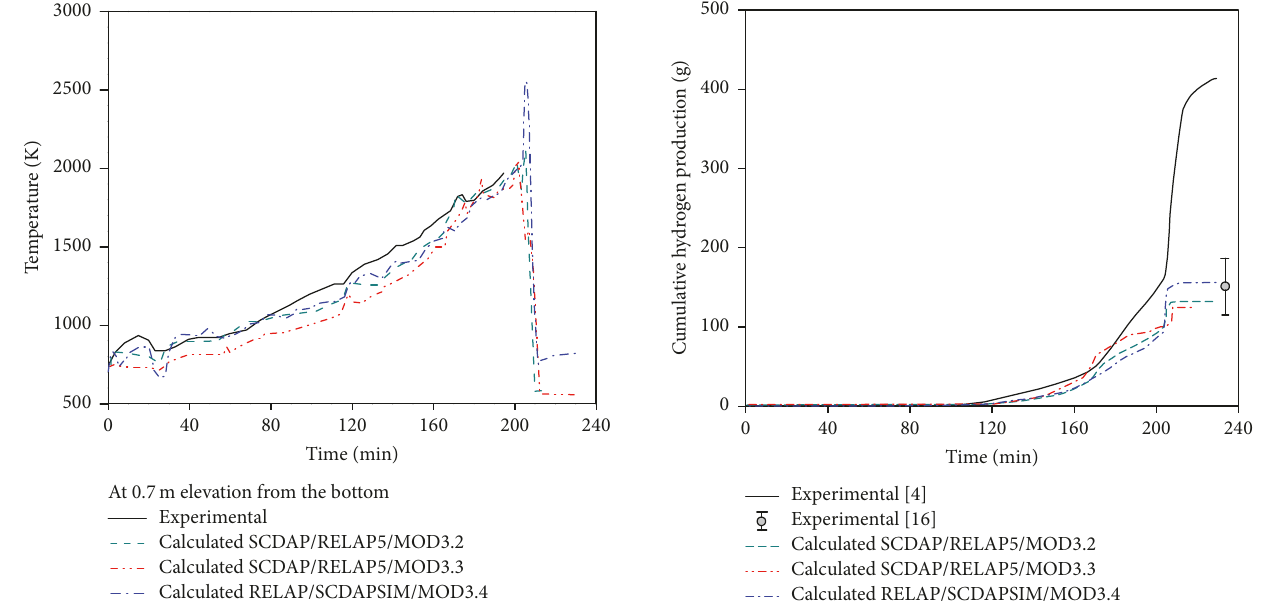
Figure 9: Comparison of measured and calculated cladding tem- peratures at 0.7 m elevation.